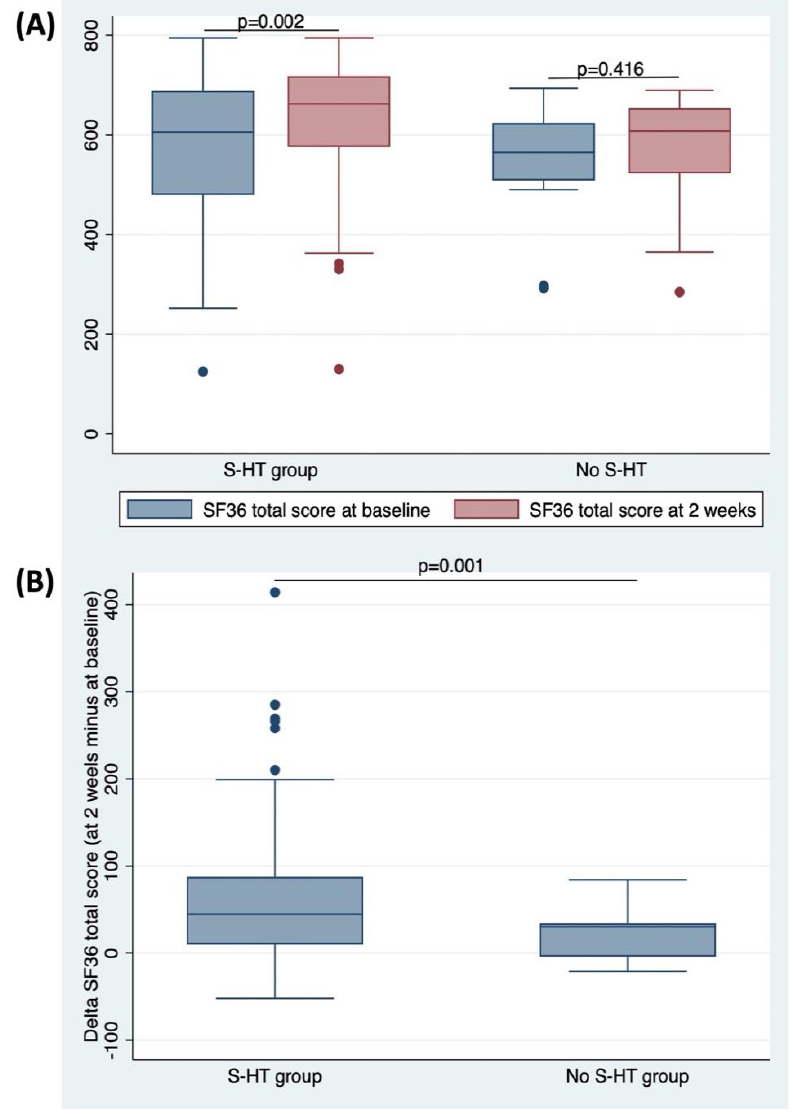
Figure 3. ( A ) SF-36 total score at baseline and at 2 weeks by groups; ( B ) differences in delta SF36 total score between the groups. Delta value was calculated as the difference between scores at 2 weeks and levels at baseline. Table 3. Comparison of the scores expressed as mean values ± SD, calculated on the scales of the SF-36 questionnaire administered at baseline and at 2 weeks in S-HT and No S-HT groups.